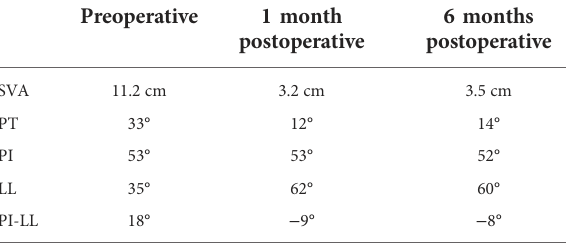
TABLE 2 The index of the blood coagulation and cardiomyocyte injury markers were shown preoperatively, at 1 month, and at 3 months after open-heart surgery to guide the treatment and the